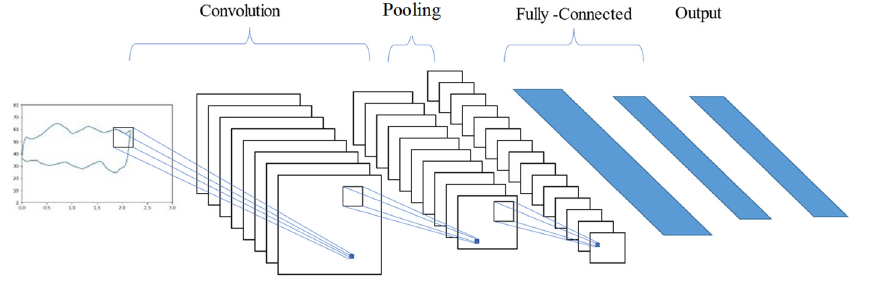
Figure 3. Example of Dynamometer Fault Types.